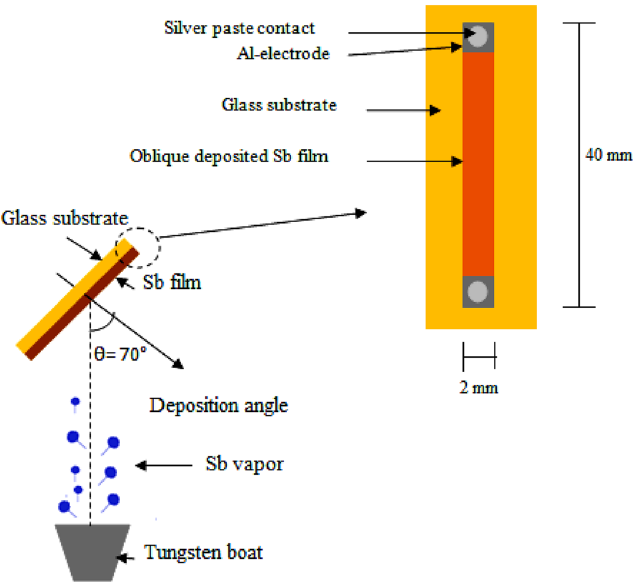
Figure 1. Oblique angle deposition set-up with configuration of Sb thin film